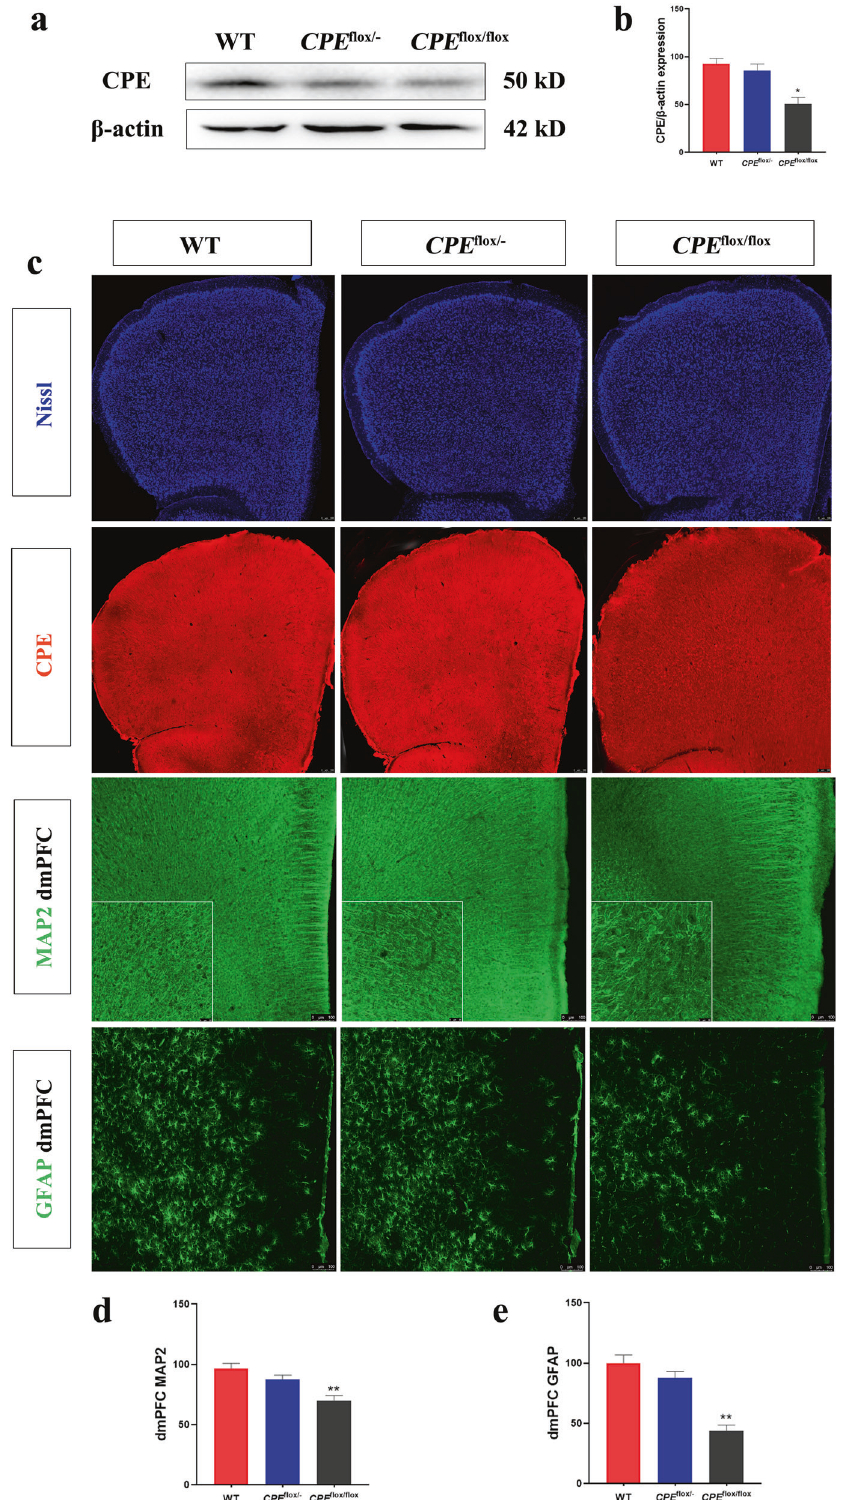
Fig. 5 CPE fl ox/ fl ox mice show a reduction in GFAP and MAP2 intensity after the stress paradigm. a , b Western blot analysis of CPE levels in the PFC. c Nissl and immuno fl uorescence staining of CPE, MAP2, and GFAP in the dmPFC of WT, CPE fl ox/- , and CPE fl ox/ fl ox mice. The relative fl uorescence intensities of d MAP2 and e GFAP in WT, CPE fl ox/- , and CPE fl ox/ fl ox mice at 100× and 400× (square in the panel). n = 6; * P < 0.05 and ** P < 0.01 compared with WT; values are mean ±